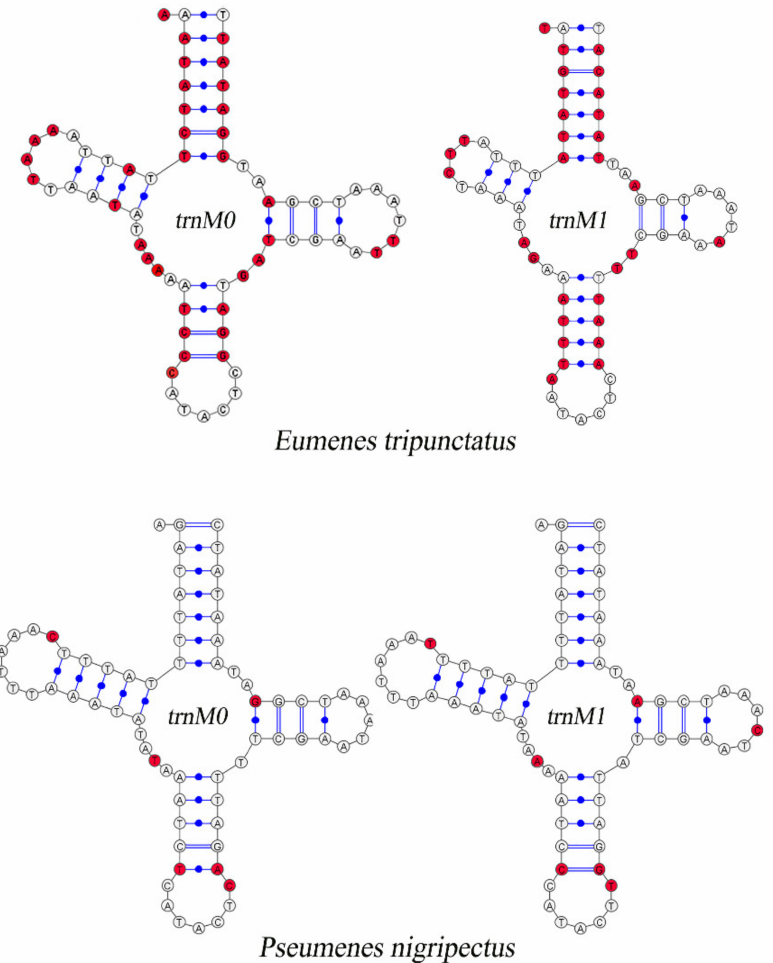
Figure 2. Inferred secondary structures of duplicated trnM . The substitutions in trnM0 and trnM1 compared with each other are indicated by red